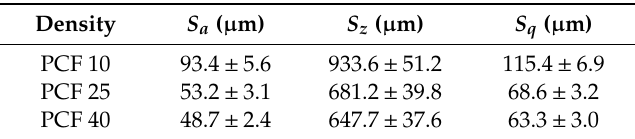
Table 2. Surface roughness measurement results for the tested samples.